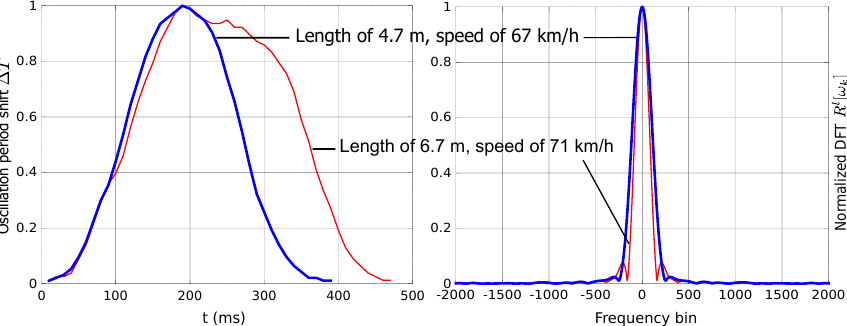
Figure 6. Experimental results: Examples of captured signatures.